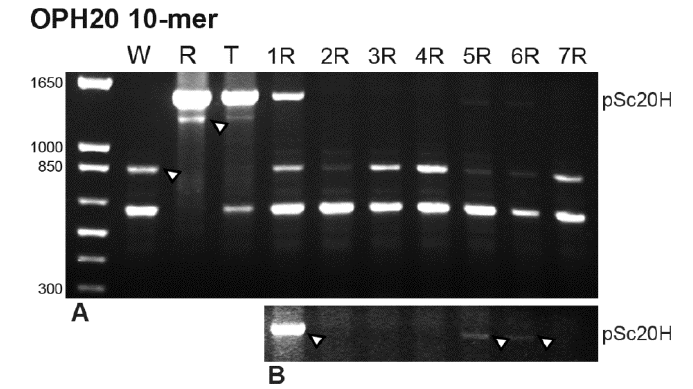
Figure 1. OPH20 10-mer primer PCR banding profiles of wheat (W), rye (R), triticale (T) and seven wheat-rye addition lines (numbers correspond to rye homologous chromosomes pair). ( A ) Arrows indicate a wheat-origin band absent in triticale but present in all wheat-rye addition lines and a rye-origin band present in triticale but absent in all addition lines. ( B ) An overexposed copy of A , where arrows indicate pSc20H band presence only in 1R, 5R and 6R wheat-rye addition lines. Molecular weight marker: 1 Kb Plus DNA